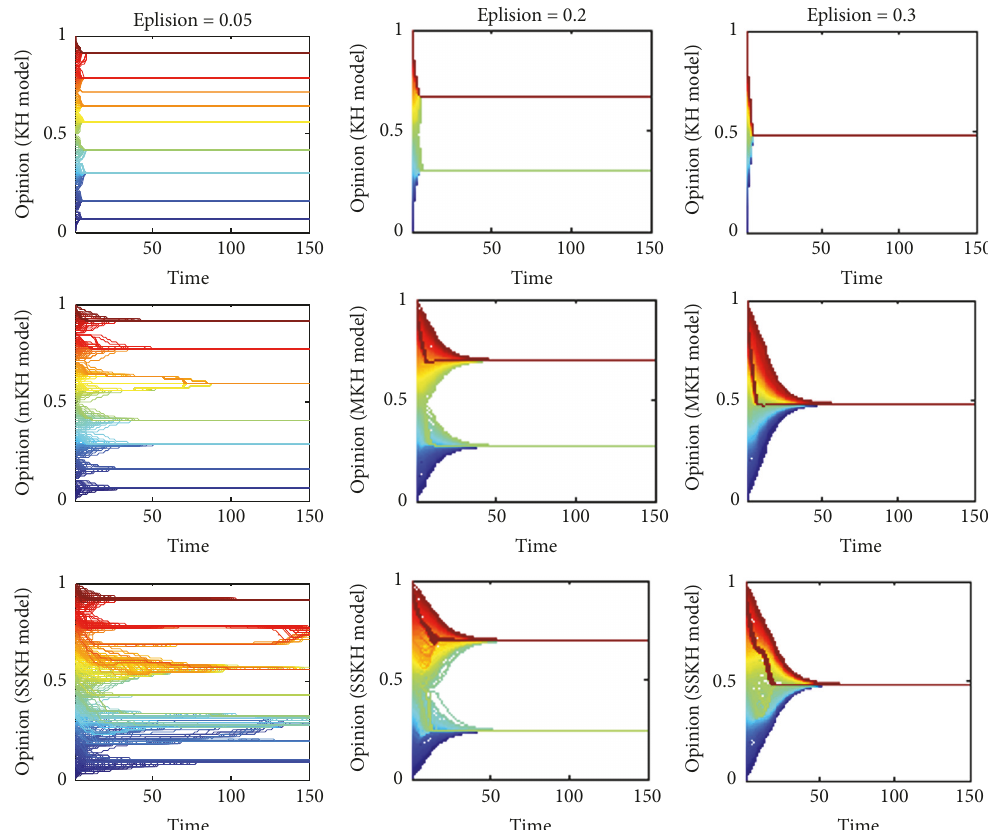
Figure 4: Opinion evolution results in the classical HK model, MHK model, and SSHK model with different confidence bounds ( 𝑤 𝑠 = 0.3 , 𝑠 = 0.1 ). threshold